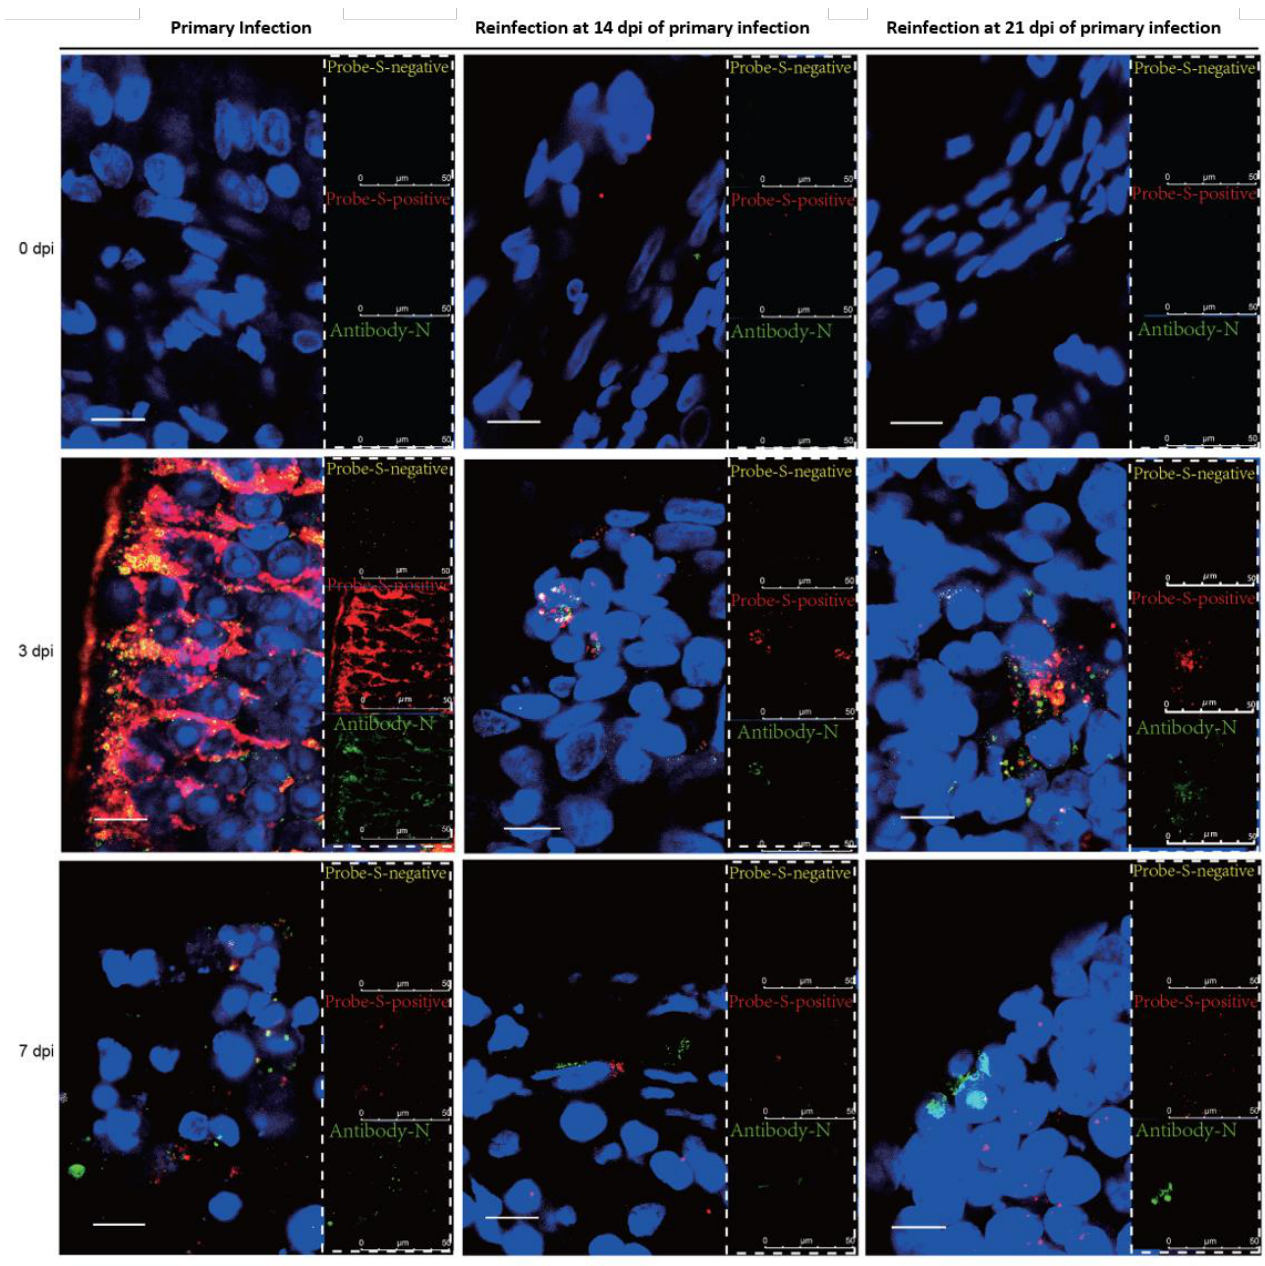
Figure 4. Viral distribution and replication were present in the nasal mucosa in the reinfection, while higher levels of viral replication were observed during primary infection. The distribution and replication of SARS-CoV-2 S-mRNA and N-protein in the nasal mucosa were detected by RNAscope- IF codetection and were detected at 0 dpi, 3 dpi, and 7 dpi in the primary and secondary infection groups. Yellow represents the S-mRNA-negative strand, and the signals represent the level of SARS-CoV-2 replication; red represents the S-mRNA-positive strand, and the signals represent the level of SARS-CoV-2 abundance; green represents the N-protein, and the signals represent the level of SARS-CoV-2 abundance. The scale is 10 µ